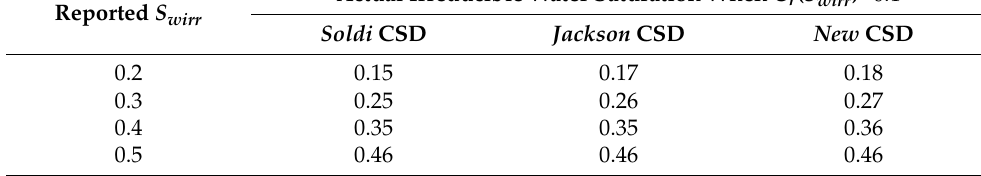
Table 7. Actual irreducible water saturation of the Berea sample for various reported irreducible water saturations when C r ( S wirr ) = 0.1, assuming the presence of a thick electrical double layer. Actual irreducible water saturations determined for Soldi , Jackson and New distribution functions with capillaries of alternating radius and model porosity of 18.75%, when r max = 100 µ